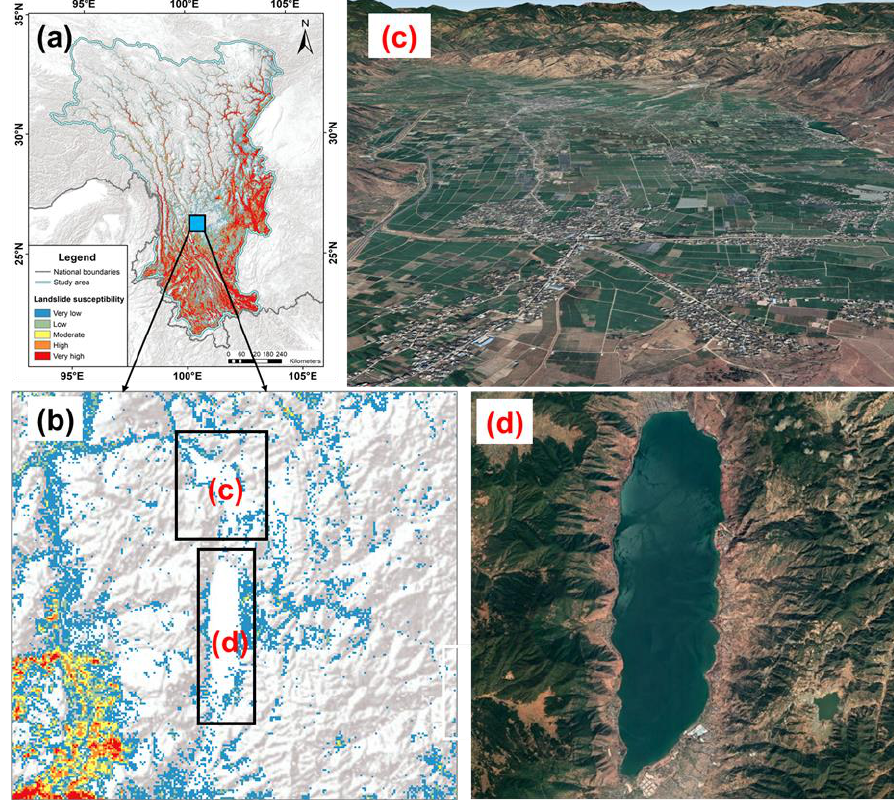
Figure A3. LS values of lake and intermountain plain areas are zero. ( a ) is the LS map of the Hengduan Mountains region. ( c ) is a 3D rendering of the plain area from ( b ) and ( d ) is an aerial view of the lake area from ( b ).